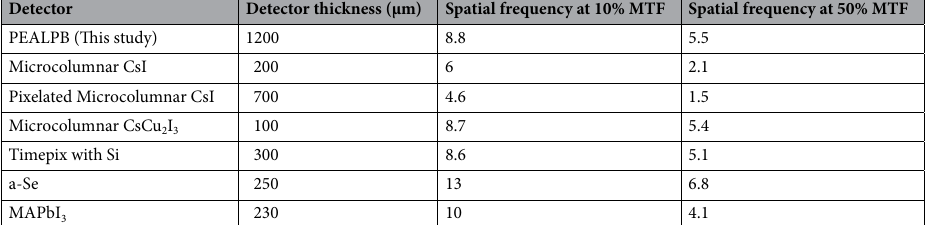
Table 1. Comparison of ultrahigh spatial resolution PEALPB detectors with the current state-of-the-art. The PEALPB detector demonstrates the best thickness to spatial resolution balance, thereby providing an unparalleled solution for detector efficiency and spatial resolution 16–20